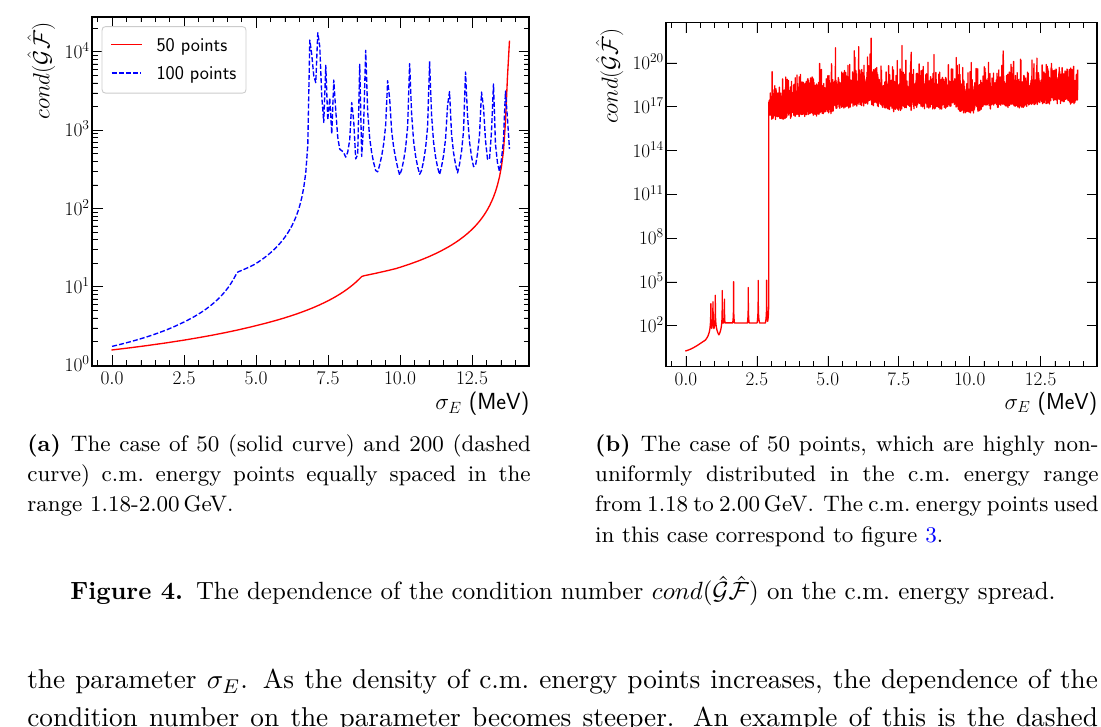
the parameter σ . As the density of c.m. energy points increases, the dependence of the E condition number on the parameter becomes steeper. An example of this is the dashed curve shown in the same figure. This curve also represents the dependence of the condition number on the c.m. energy spread, but obtained at twice the density of c.m. energy points than the solid curve. Some oscillations are observed on the dashed curve when the energy spread exceeds 6 MeV. Similar oscillations are observed for the solid curve too, but they appear outside the figure starting at about 14